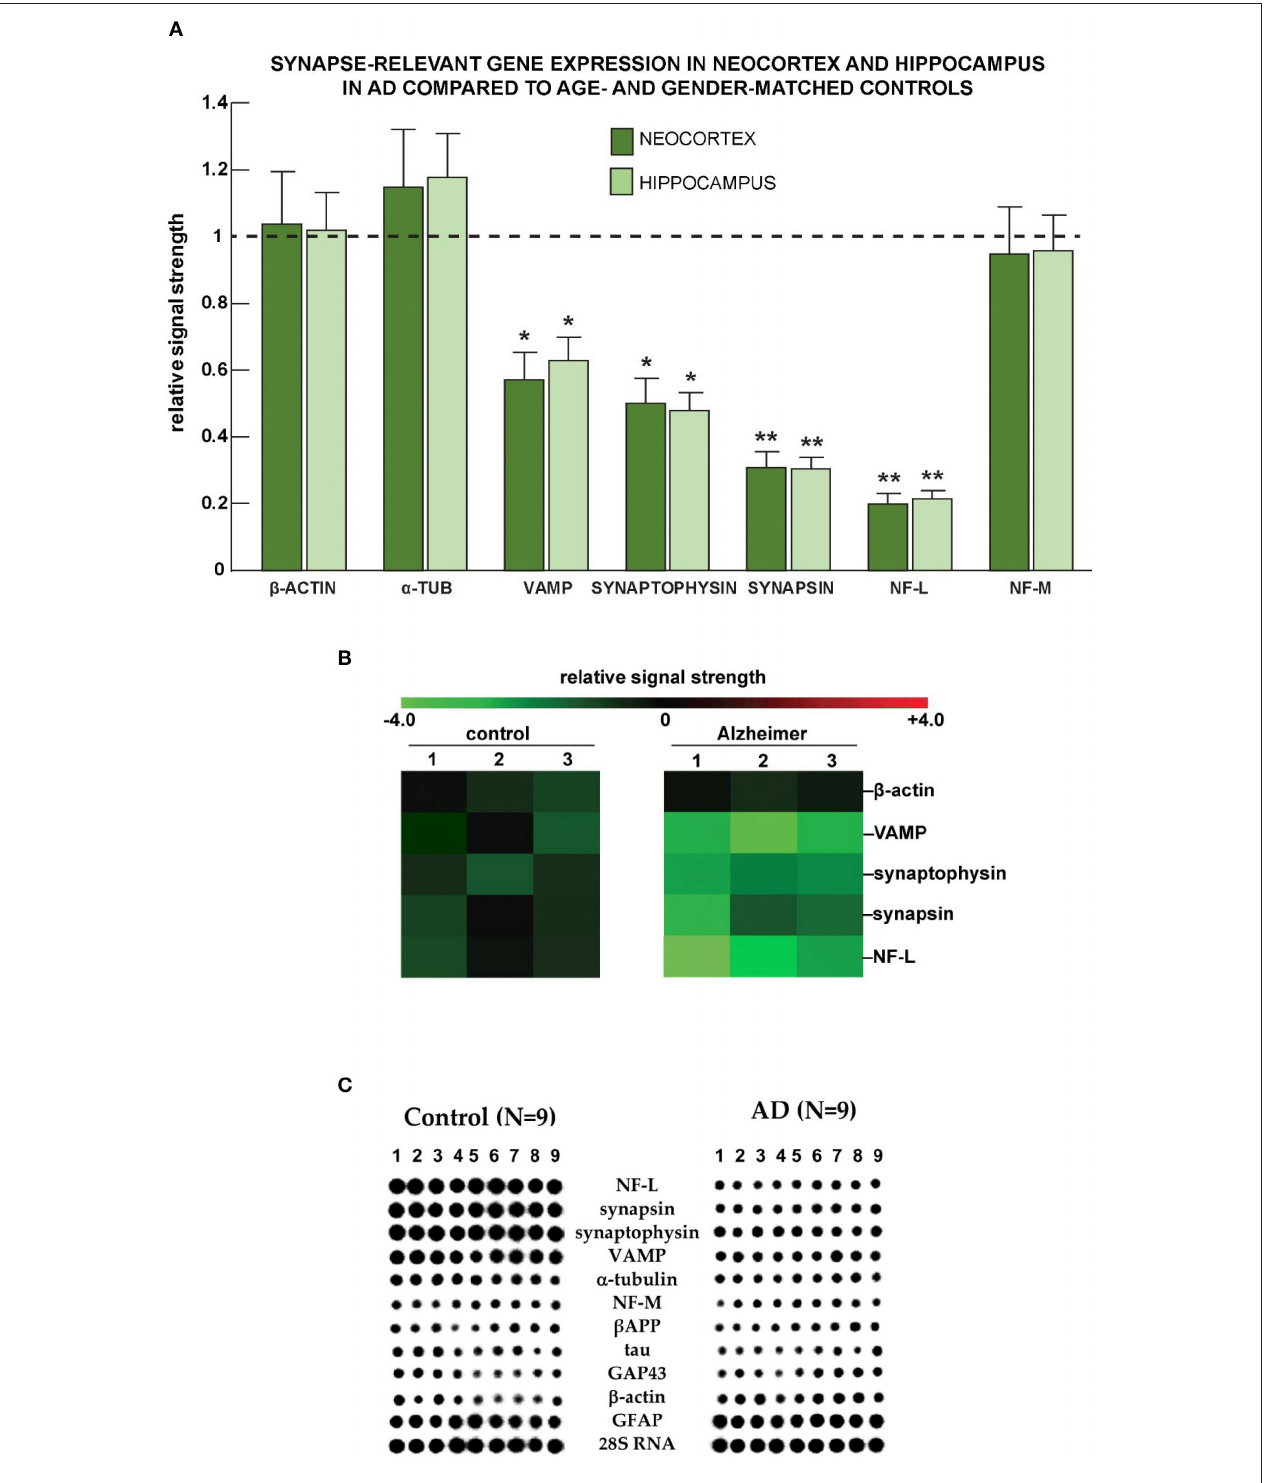
FIGURE 5 | Selective down-regulation of the expression of genes coding for synaptic proteins in AD. (A) Neocortical and hippocampal down-regulation of VAMP, synaptophysin, synapsin, and the neuron-specific neurofilament light (NF-L) chain messenger RNA in Alzheimer’s disease vs. age-, gender-, and post mortem interval-matched controls using the β -actin cytoskeletal as an internal “housekeeping gene” and expression control. Importantly, the low abundance of the